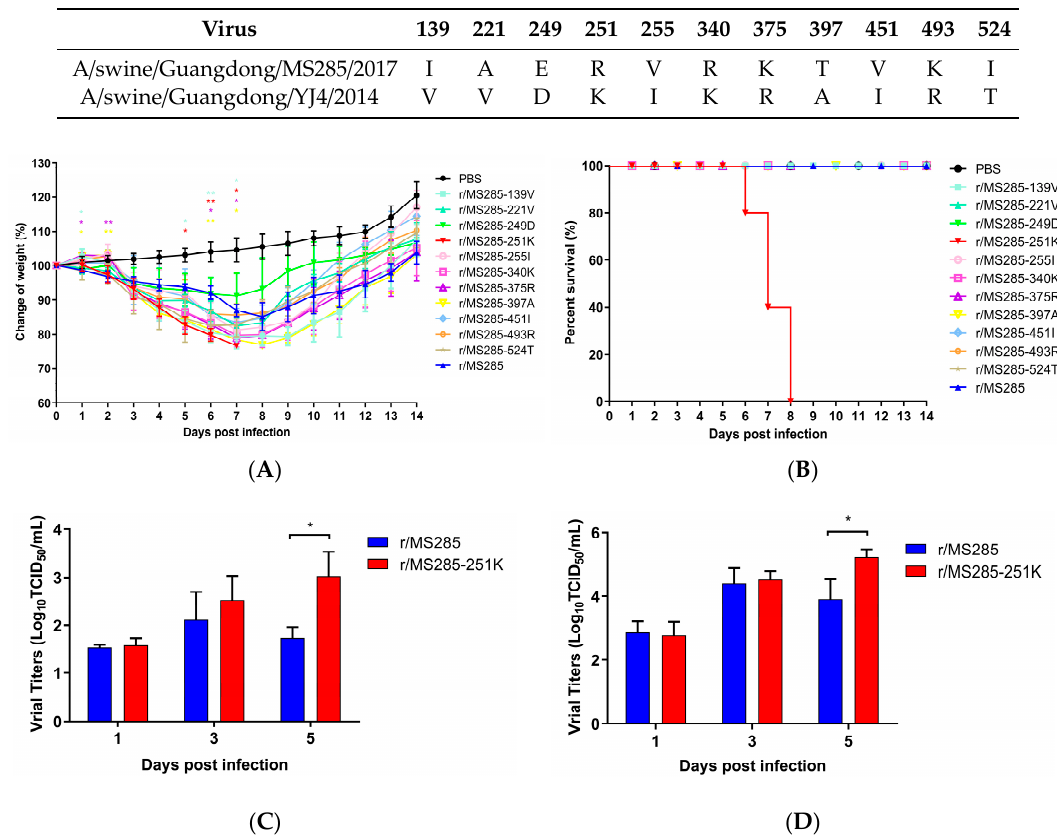
Table 3. Amino acids differences in PB2 proteins among MS285 and YJ4 viruses.